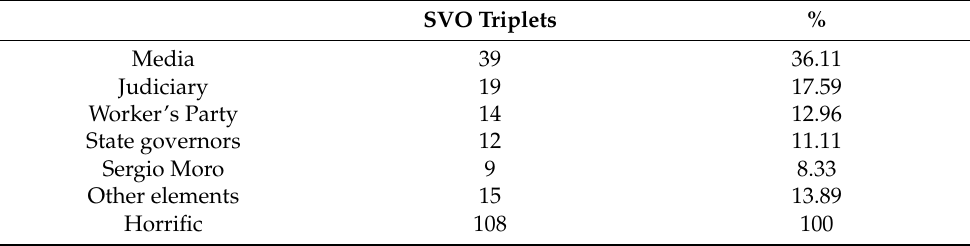
Table 19. Horrific dimension of fantasy in Bolsonaro’s Twitter